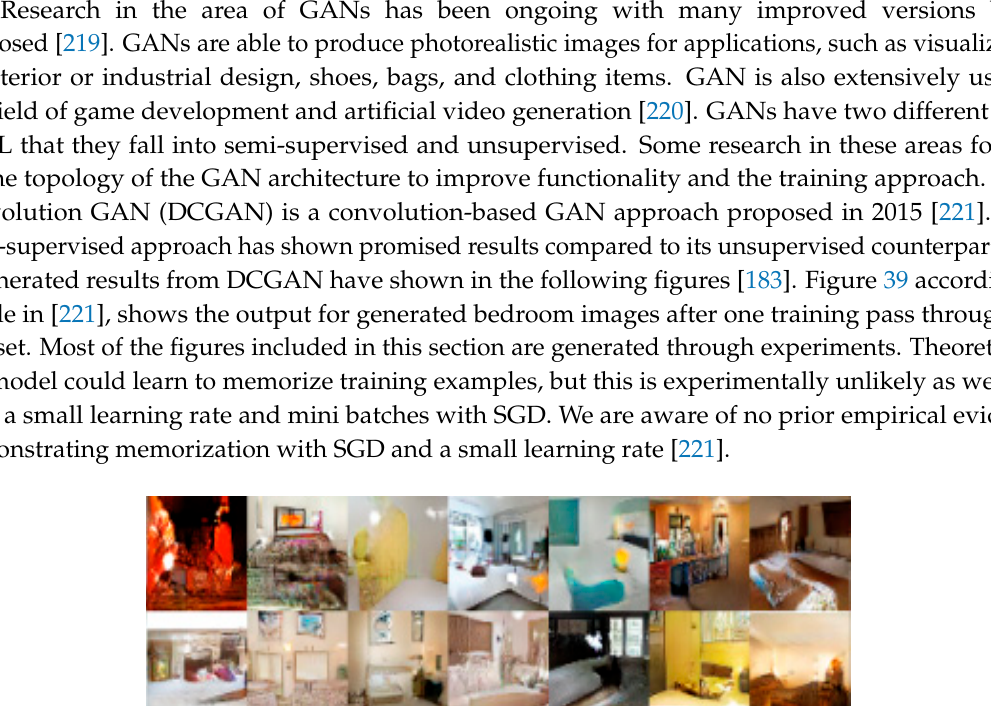
Figure 40. Reconstructed bedroom images using deep convolution GAN (DCGAN). In Figure 40, according to article in [221], the top rows interpolation between a series of nine random points in Z, and show that the learned space has smooth transitions. In every image, space plausibly looks like a bedroom. In the 6th row, you see a room without a window slowly transforming into a room with a giant window. In the 10th row, you see what appears to be a TV slowly being transformed into a window. The following Figure 41 shows the effective application of latent space vectors. Latent space vectors can be turned into meaning output by first performing addition and subtraction operations followed by a decode. Figure 41 according to article in [221], shows that a man with glasses minus a man and add a woman which results in a woman with glasses. Figure 41. Example of smile arithmetic and arithmetic for wearing glass using GAN: a man with glasses minus man without glasses plus woman without glasses equal to woman with glasses. Figure 42, according to article in [221], shows a turn vector was created from four averaged samples of faces looking left versus looking right. By adding interpolations along this axis of random samples the pose can be reliably transformed. There are some interesting applications that have been proposed for GANs. For example, natural indoor scenes are generated with improved GAN structures. These GANs learn surface normal and are combined with a Style GAN by Wang and